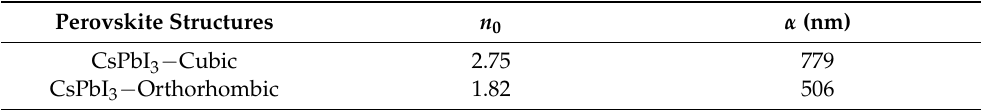
Figure 7. ( a ) Optical absorption spectrum (the absorption edges are shown by yellow circles), ( b ) Refraction spectrum of CsPbI 3 for the cubic and orthorhombic phases. Table 6. Wavelength of absorption edge and refraction index of CsPbI 3 structure for the cubic and orthorhombic